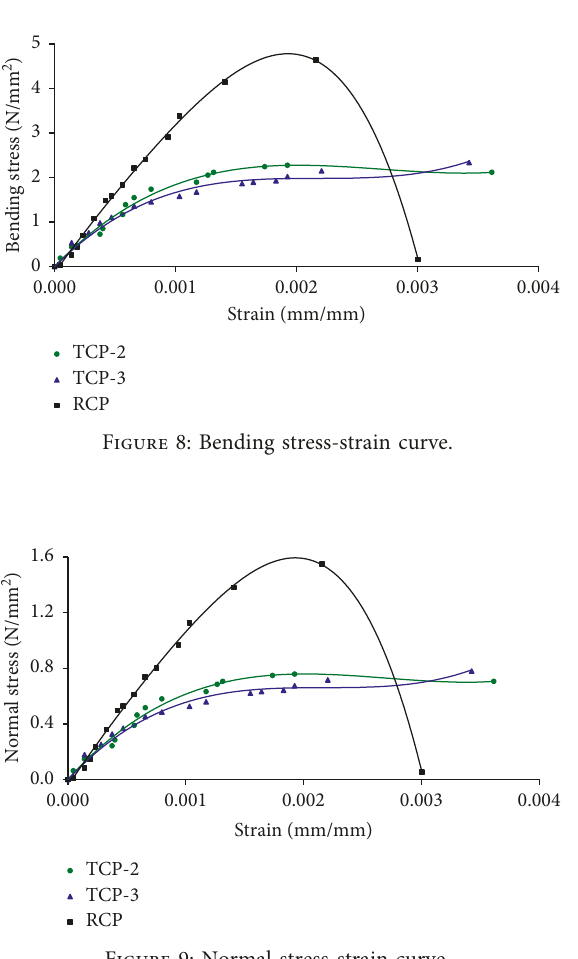
Figure 9: Normal stress-strain